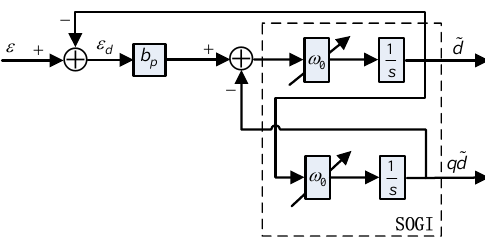
Figure 10. Control block diagram of the second-order generalized integrator